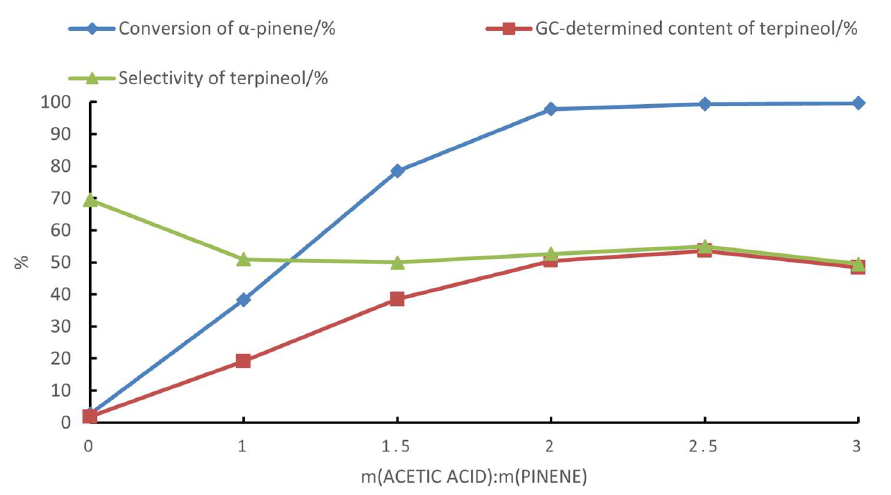
Figure 2. The effect of acetic acid on the hydration of α-pinene. The reaction conditions were m(α- pinene)/m(water)/m(citric acid)/m(boric acid) = 10:10:1:0.4, a reaction temperature of 60 °C, and a reaction time of 24 h.